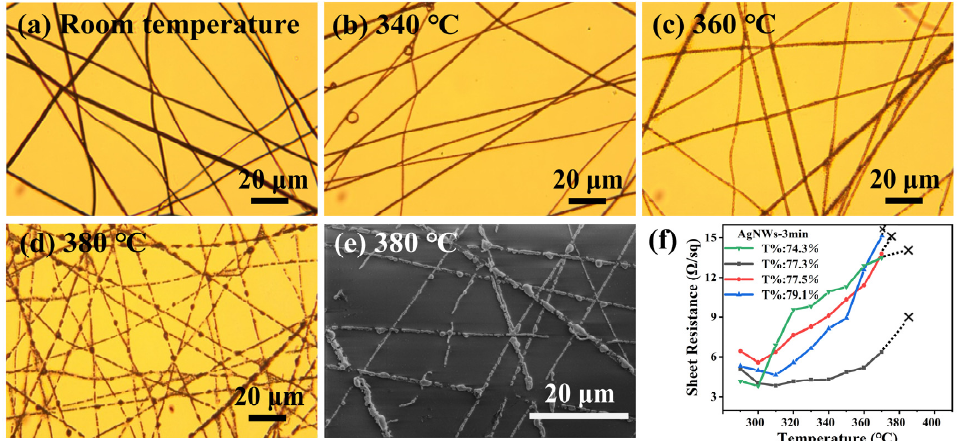
Figure 4. ( a – d ) Micrograph of AgNW films treated at different temperatures. ( e ) The FESEM morphology of AgNW films treated at 380 °C. ( f ) Relation diagram of temperature and sheet re- morphology of AgNW films treated at 380 ◦ C. ( f ) Relation diagram of temperature and sheet resistance sistance of AgNWs. Where T% is the transmittance . of AgNWs. Where T% is the